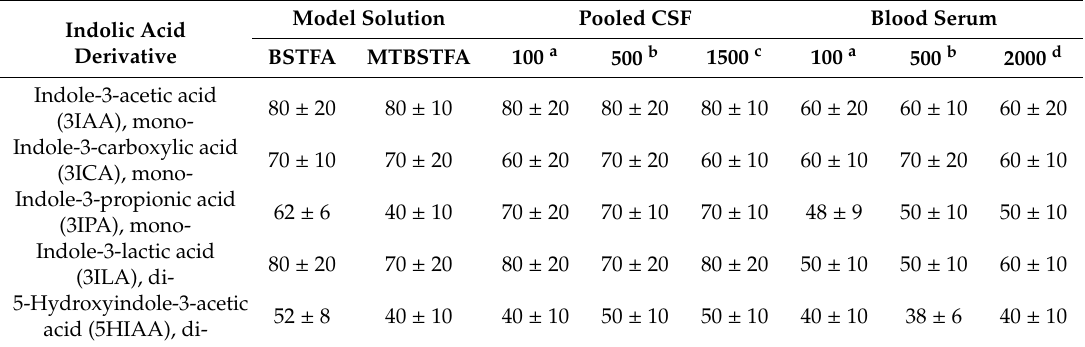
Table 3. Recoveries (%) of the silyl derivatives of indolic acids from model solution (derivatization with N , O -bis(trimethylsilyl)trifluoroacetamide (BSTFA) or N -( tert -butyldimethylsilyl)- N -methyltrifluo roacetamide (MTBSTFA)), pooled cerebrospinal fluid (CSF) samples and serum samples at three concentration levels using microextraction by packed sorbent (MEPS) as a sample preparation technique and BSTFA as a derivatizing reagent ( n = 3, p = 0.95). Model Solution Indolic Acid Derivative